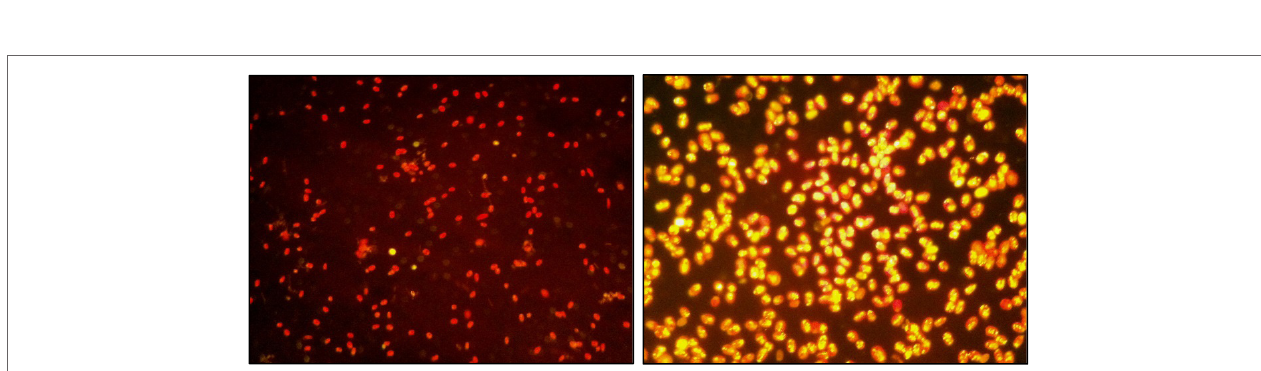
FigUre 2 | Photograph of pilot-scale two-stage microalgae cultivation system . Individual modules were used for single testing of photobioreactor or open